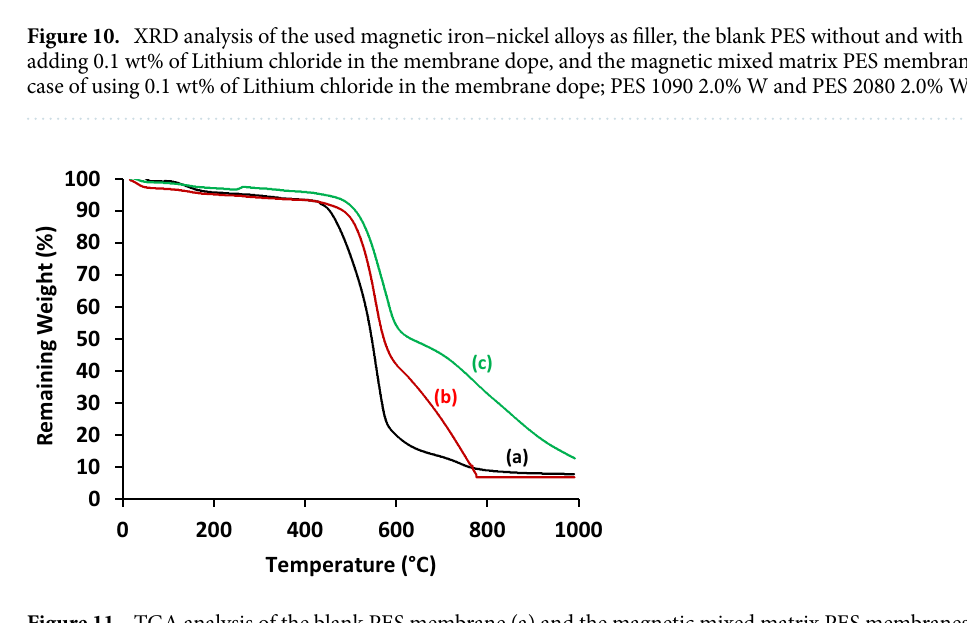
Figure 11. TGA analysis of the blank PES membrane (a) and the magnetic mixed matrix PES membranes (b; PES 1090 2.0% and c; PES 2080 2.0%) in case of using 0.1 wt% of Lithium chloride